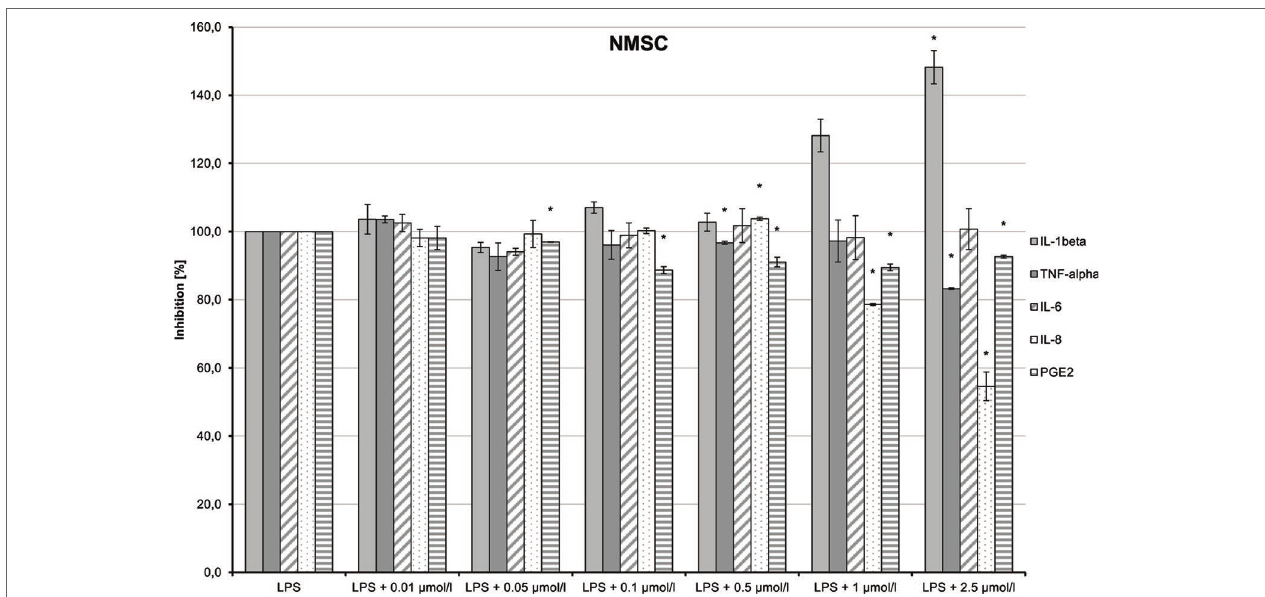
FigURE 15 | Pro‑inflammatory and anti‑inflammatory effects of 2‑(methylsulfonamido)ethyl cannabidiolate (NMSC) on primary human monocytes; normalized to the induction by lipopolysaccharide (LPS) (without the addition of test compounds); n = 2 independent experiments; error bars show SEM, * p < 0.1.